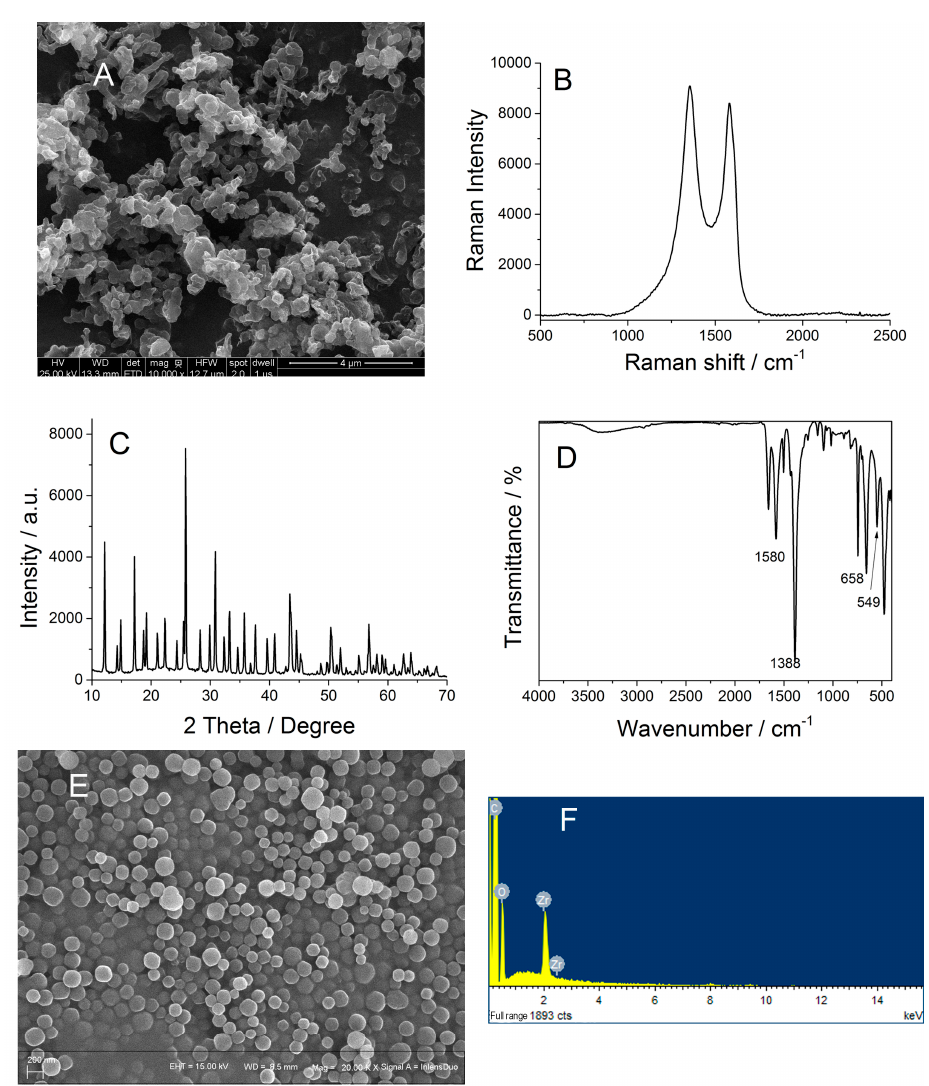
Figure 1. ( A ) SEM image and ( B ) Raman spectrum of rGO. ( C ) XRD pattern, ( D ) FTIR spectrum, ( E ) SEM image and ( F ) element mapping of prepared UiO-66.